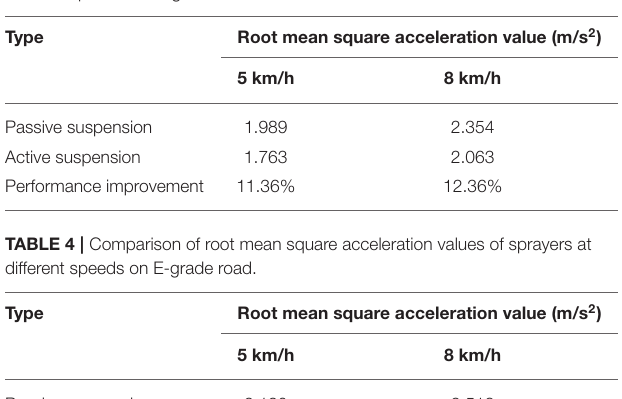
TABLE 3 | Comparison of root mean square acceleration values of sprayers at different speeds on D-grade road.